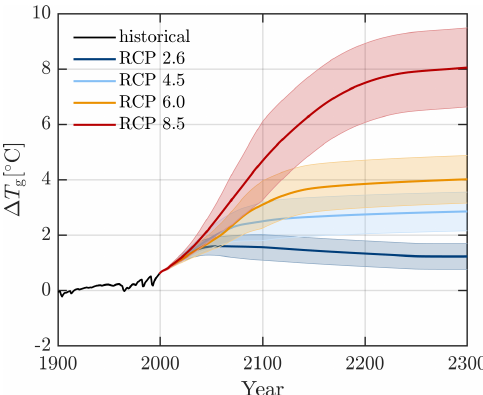
Figure 4. Changes in global mean temperatures ( (cid:49)T g [ ◦ C]) relative to pre-industrial levels for four Representative Concentration Path- ways (RCPs) 2.6 (blue), 4.5 (green), 6.0 (yellow), and 8.5 (pink). Shading shows uncertainty regions between the 25th and 75th per-